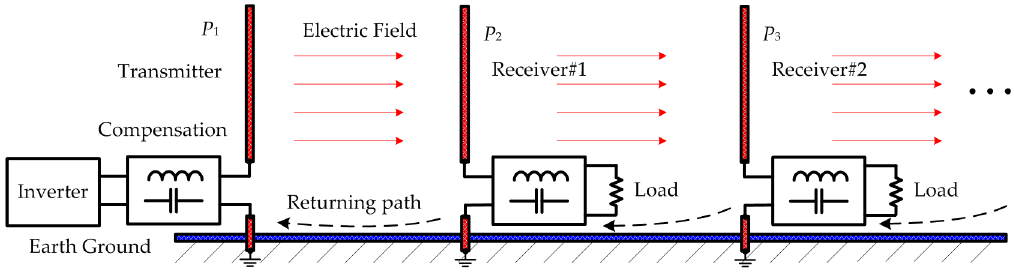
Figure 26. An electric field repeater system based on two-plate coupler structure.